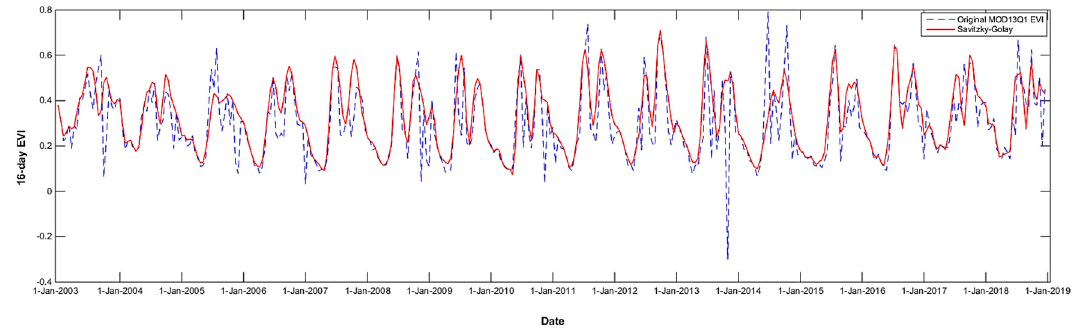
8 of 16 Figure 5. A training sample of 1-season maize crop class over a MOD13Q1 grid (in white) and a high spatial resolution image of Google Earth Pro taken on 18 February 2019. The accuracy assessment of the produced map was evaluated using the other independent GPS surveyed data of 121 locations covering different land cover/land use types through a confusion matrix. The user’s, producer’s and overall accuracy indices, and the Kappa’s statistic, were all examined. In addition, we also used the 2018 official statistics, which were released in December 2019, at district level to compare the total maize cultivated area of each district with the maize areas estimated via the utilization of SVM classifier on SG-reconstructed EVI data. This was done by examining the coefficient of correlation ( r ) and the root-mean-square deviation ( RMSD ). 3. Results 3.1. Reconstruction of MOD13Q1 EVI Time Series for Vegetation Phenology Detection Using Savitzky– Golay Filter Figure 6 shows how differently the profile of the original EVI time series presents the 2-cropping season maize class from that of the SG reconstructing filter. The original data does include negative EVI value due to cloud and/or noisy condition. Moreover, in the original curve, the number of maize crops per year can roughly be identified, but those patterns are not well-defined. There is no clear